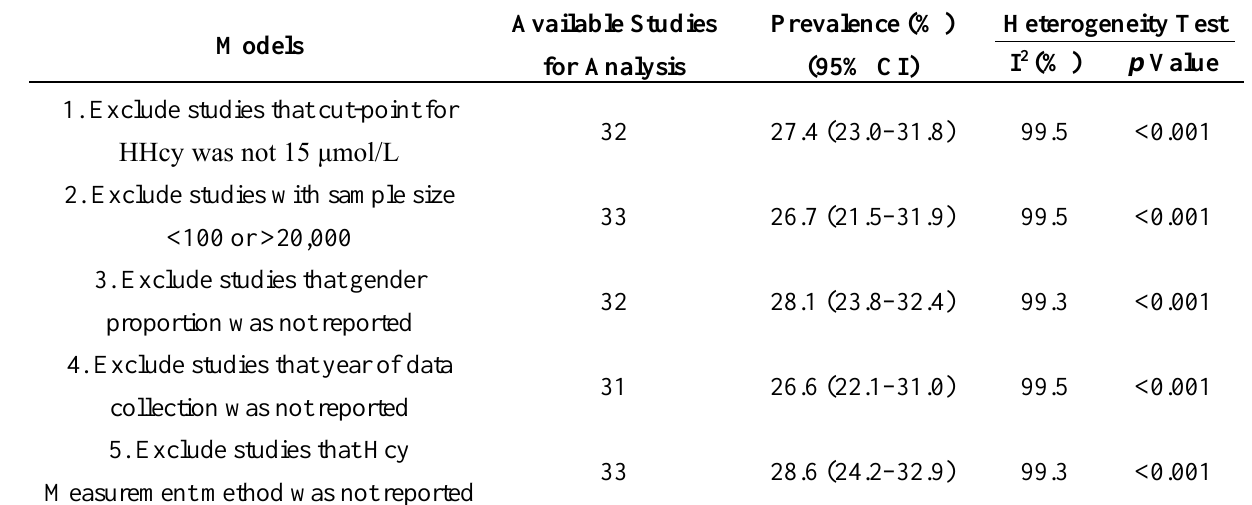
Figure 3. Forest plot of the prevalence of hyperhomocysteinemia in China. Table 2. Sensitivity analyses of pooled prevalence of HHcy in